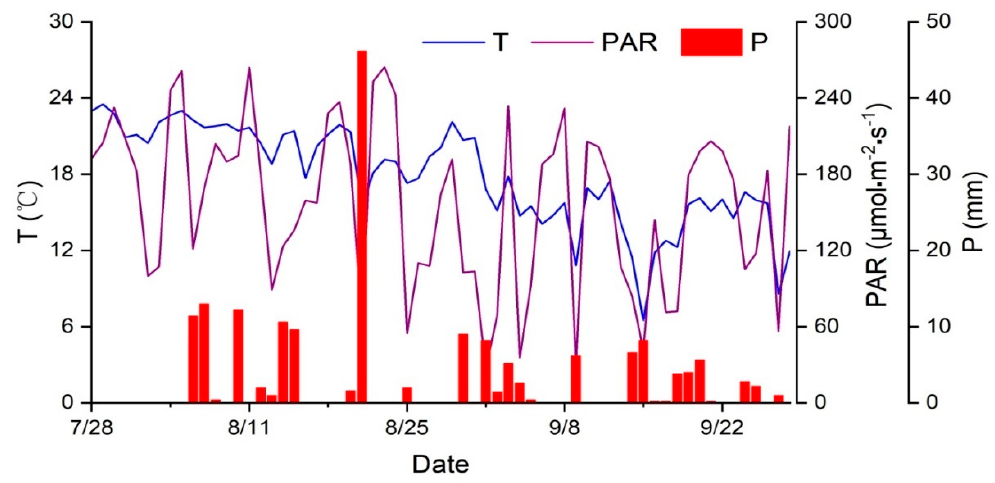
Figure 2. Daily air temperature (T), photosynthetically active radiation (PAR), and precipitation (P) during the study period.